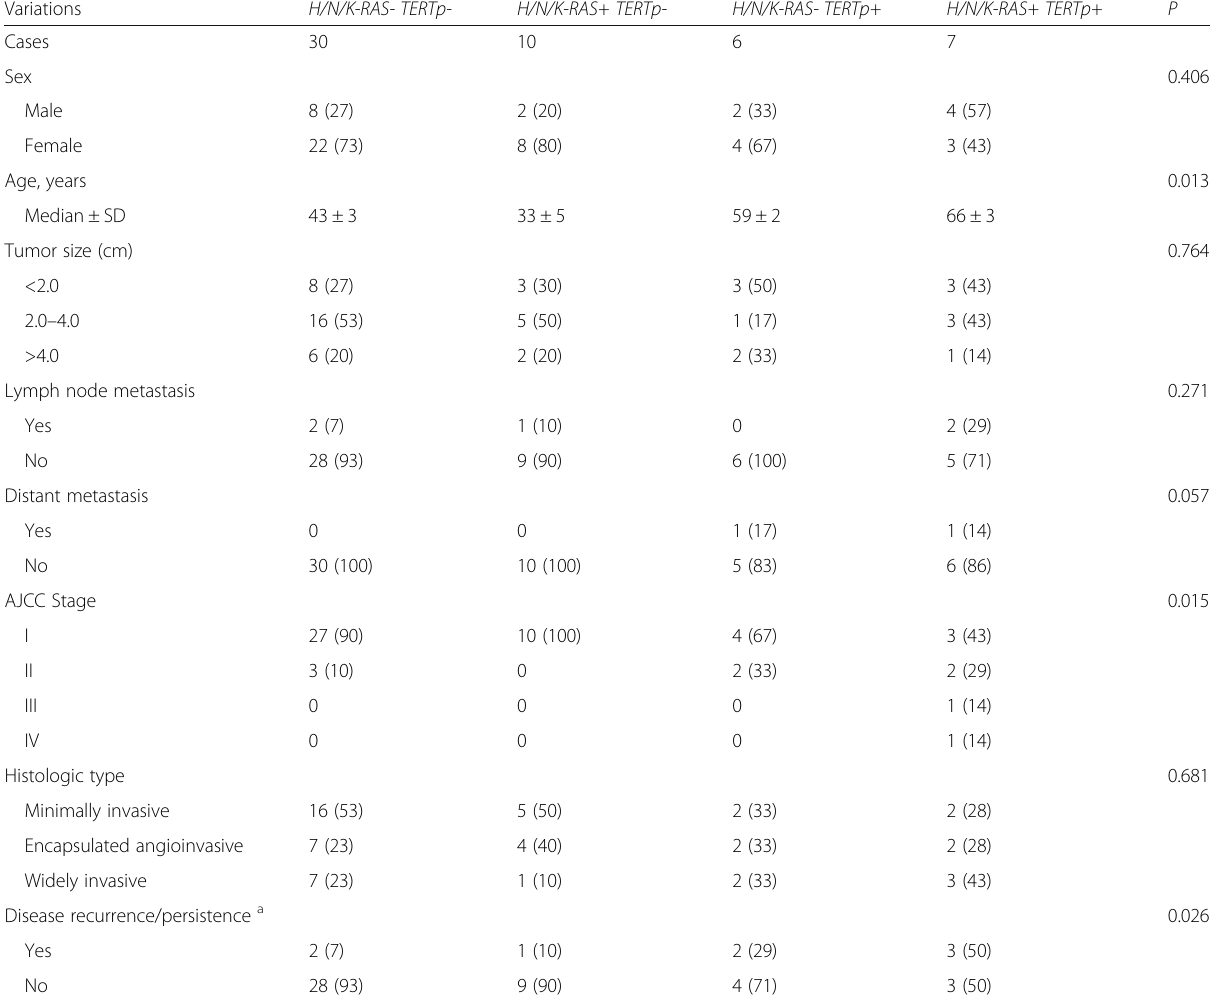
Table 3 Association of TERTp and H/N/K-RAS mutations with clinicopathological featurs in 53 FTC patients Variations H/N/K-RAS- TERTp-